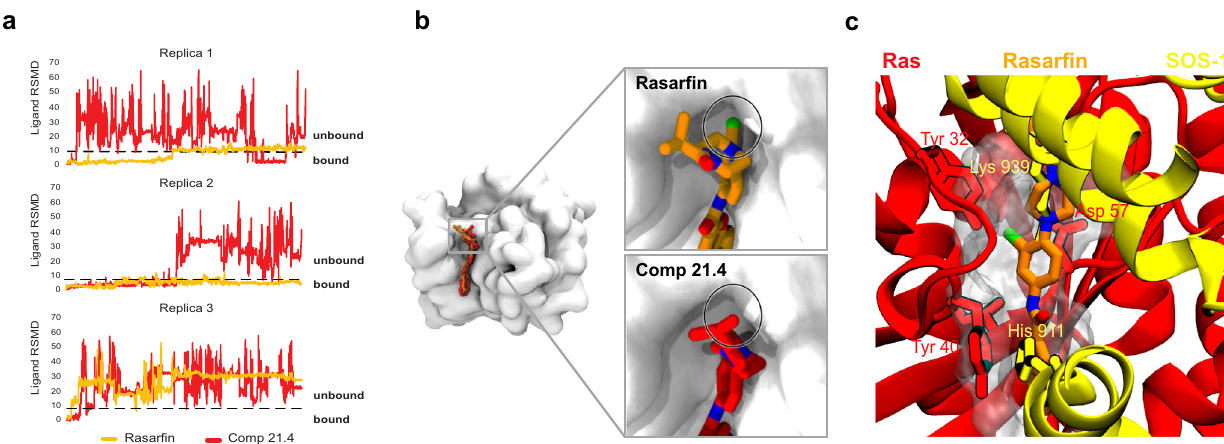
Fig. 6 Estimation of the stability of Rasar fi n and compound 21.4 binding modes. a Root Mean Square Deviation (RMSD) ( y axis) for Rasar fi n (orange) and 21 . 4 (red) in respect to their initial position were analyzed in three separate MD runs. RMSD values higher than 6 correspond to simulation frames in which the ligand fully unbinds. The ligand position was monitored across 3 separate replicates of 4 μ s (total 12 μ s). b Comparison of predicted binding mode of Rasar fi n (orange licorice) and compound 21 . 4 (red licorice). The molecular surface of Ras is represented in white and reveals the presence of a structural cavity in the vicinity of the predicted binding modes (black circle). In the predicted binding mode of Rasar fi n, the structural cavity is occupied by the chlorine atom (in green), which is missing in compound 21 . 4 . c Overlay of Rasar fi n binding into the Ras-SOS binding interface (PDB:1BKD). Rasar fi n is displayed in orange licorice, SOS in yellow, and Ras in red ribbons. The surface occupied by Rasar fi n is shown in transparent gray. Residues on Ras and SOS are highlighted in respective colors and labeled accordingly. Rasar fi n is binding in the cavity which is normally occupied by residues His911 and Lys939 of SOS. Those residues are shown superimposed with Rasar fi n, displaying His911 overlaying with the furan of the benzofuran moiety (AR1), and the Lysine elongated in the binding groove like Rasar fi n, partially hidden as they overlay perfectly.